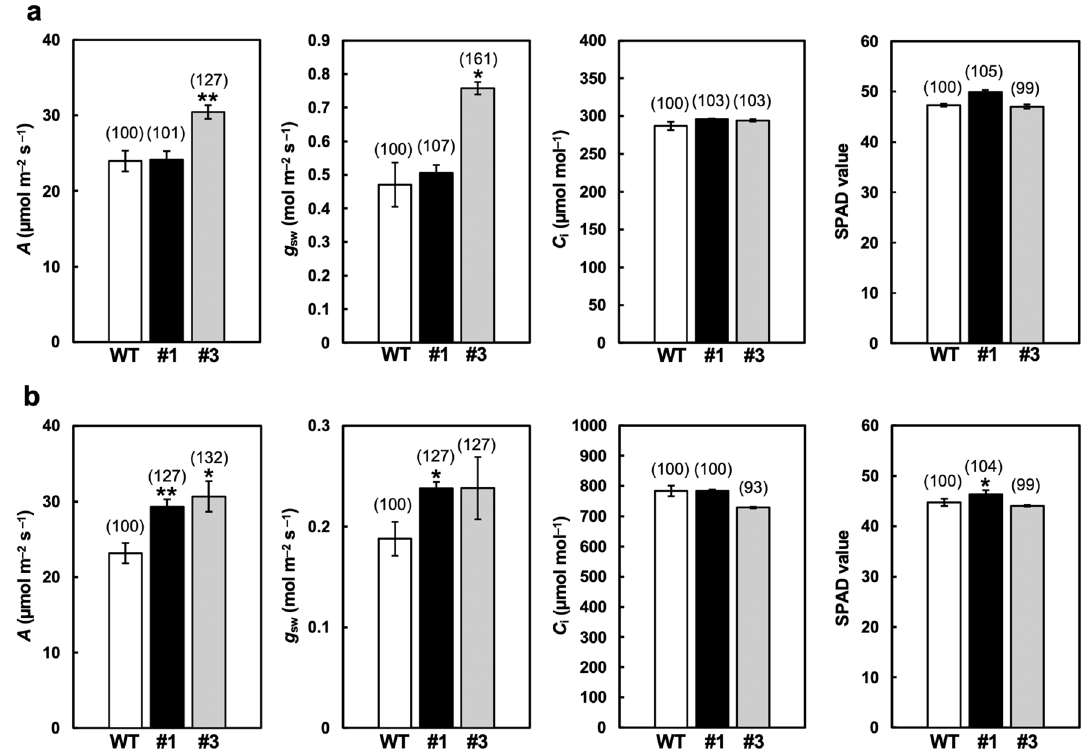
Figure 5. Photosynthesis-related characteristics in the R1 -Cas plants. The photosynthetic carbon assimilation ( A ), stomatal conductance to water vapor ( g sw ), intercellular CO 2 concentration ( C i), and SPAD value of the wild-type (WT) and R1 -Cas #1 and #3 plants in a growth chamber under ambient CO 2 ( a ) and high CO 2 conditions (1000 µmol CO 2 mol -1 ) ( b ). Data are presented as the average ± standard error of the mean ( n = 3). Asterisks indicate significant differences relative to the WT plants based on the Student’s t -test (* p < 0.05 and ** p < 0.01). Values relative to those of WT as 100 are shown in parentheses.